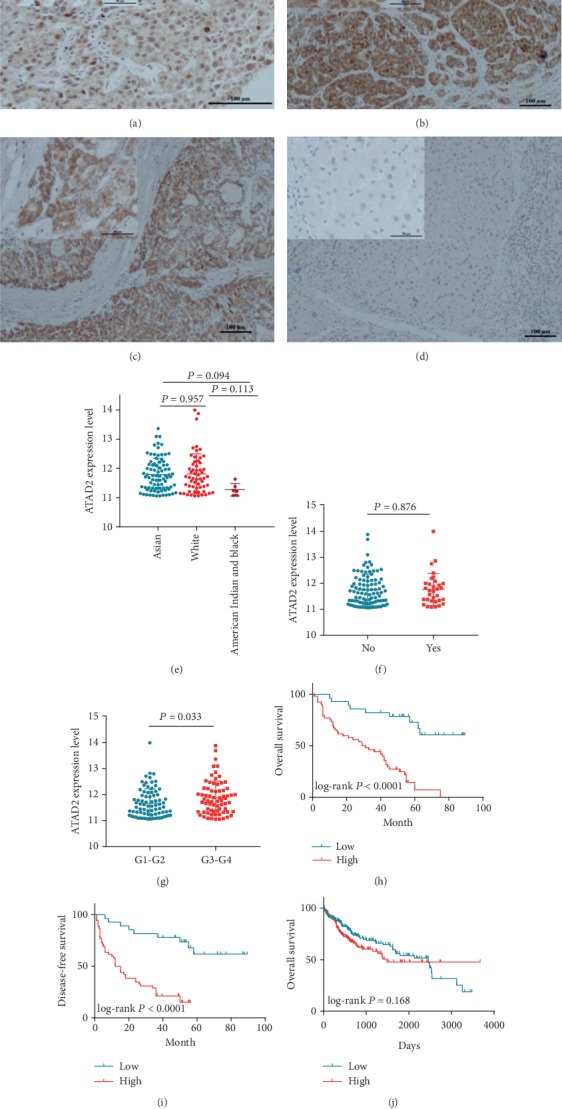
IHC staining of ATAD2 in HCC tissues and expression and prognosis of ATAD2 in HCC based on TCGA and our institutional data. Positive immunohistochemical reaction was showed as brown staining. Representative tissue sections with different immunochemical staining status (from nucleus to negative) of ATAD2: (a) nucleus: poorly differentiated; (b) cytoplasm: moderately poorly differentiated; (c) less cytoplasm: moderately differentiated; (d) negative: well differentiated. For each intensity group, the specimens were obtained (×200 and ×400 magnification). (e) Scatter plot of ATAD2 expression at different races. (f) Scatter plot of ATAD2 expression based on family cancer history. (g) Scatter plot of ATAD2 expression at different histological grades. (h) Overall survival of HCC patients related to ATAD2 status (protein level) in institutional data. (i) Disease-free survival of HCC patients related to ATAD2 status (protein level) in institutional data. (j) Overall survival of HCC patients related to ATAD2 status (mRNA level) based on TCGA data.